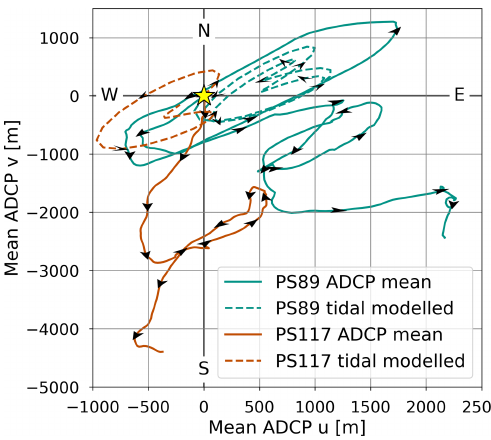
Figure F2. The hypothetical distance that a water parcel could have travelled relative to a starting point at the ship’s position (indicated by the yellow star) at the starting time of sampling during the PS89 (green) and PS117 (orange) tidal observations. Full lines show the distance travelled using the water column mean ADCP current data. Dashed values show the distance travelled using the modelled water column mean tidal current data. Black arrows indicate the direction of the currents. These calculations assume that the mean currents apply to the larger shelf and polynya region, disregard topographic influences, and ignore the presence of the ice shelf, which is located directly south of the sampling site.